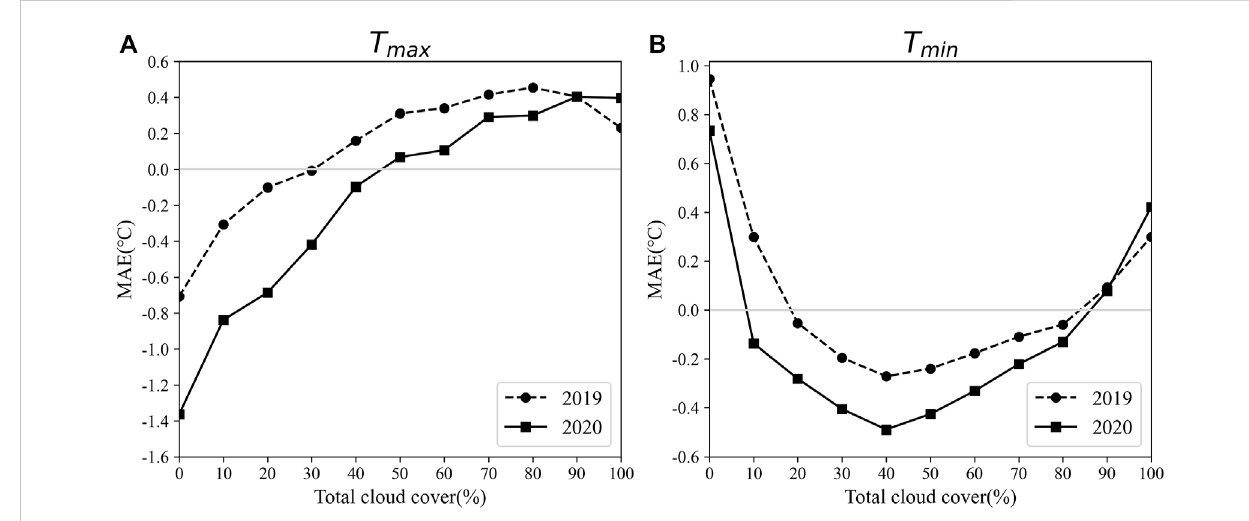
Relationship between the mean deviations of 12 – 36 h forecasts of temperature and the total cloud cover in 2019 and 2020. (A) : T max and (B) : T min